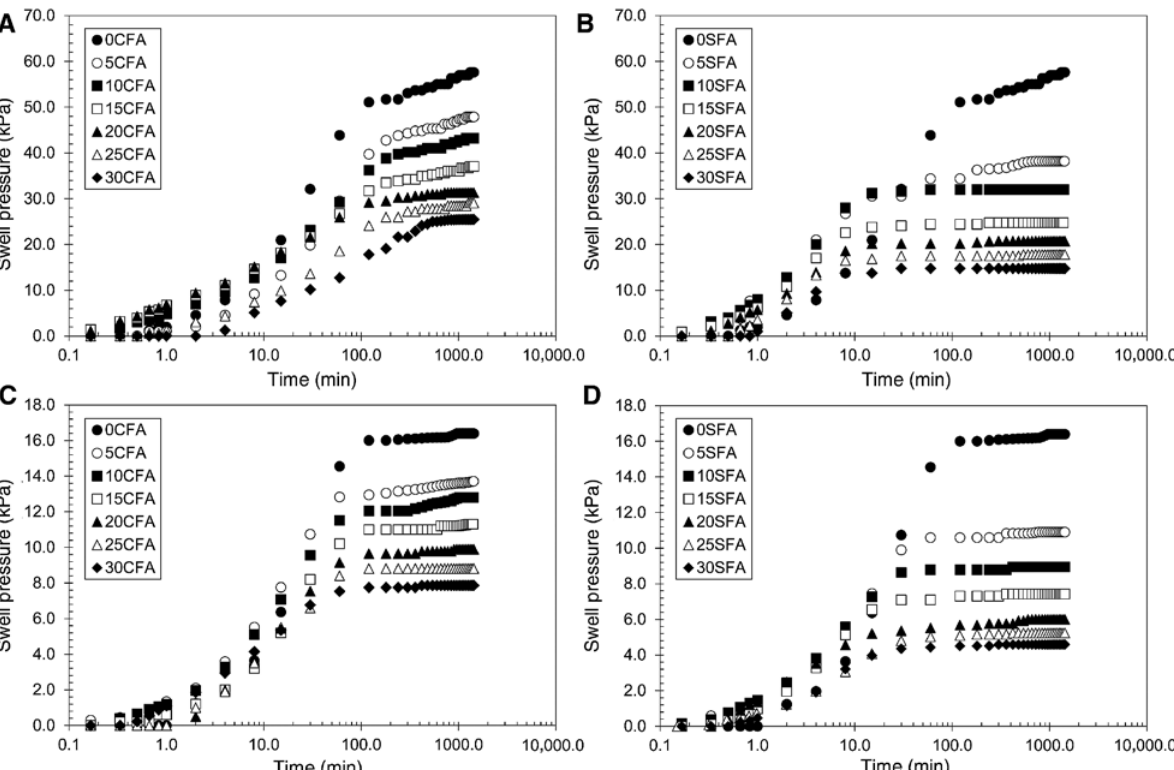
Figure 9: Swell pressure versus time plots for mixtures (A) Soil A-CFA mixtures, (B) Soil A-SFA mixtures, (C) Soil B-CFA mixtures and (D) Soil B-SFA